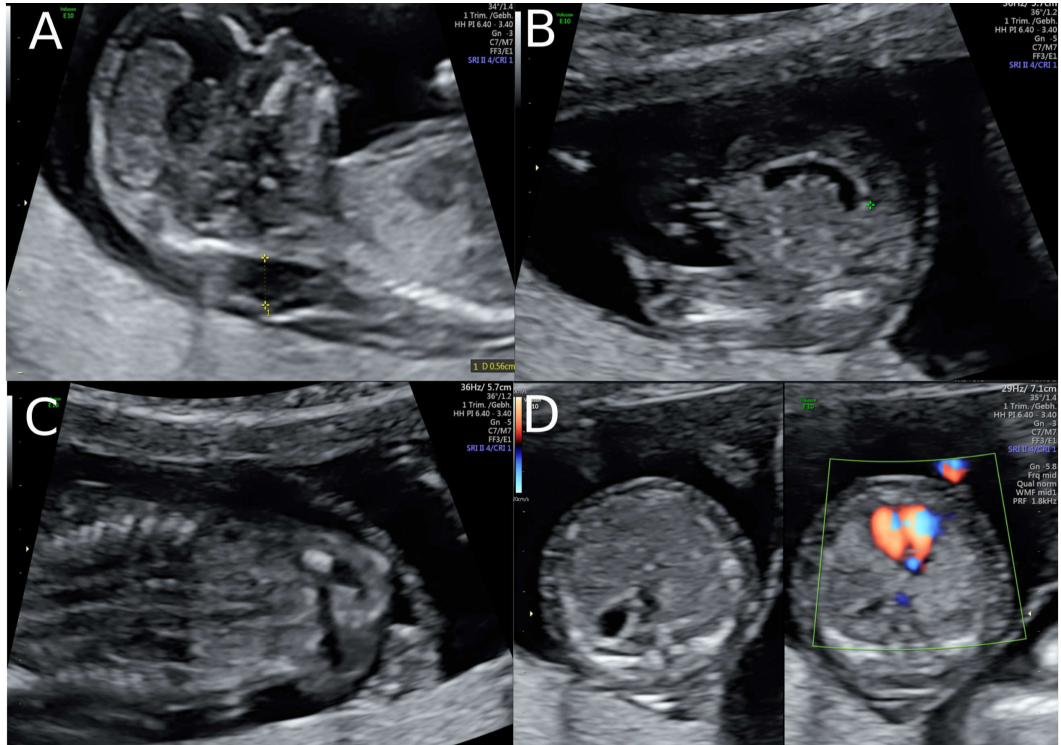
Figure 1. Ultrasound findings in the 1st Trimester. ( A ) Increased Nuchal Translucency (NT) at 13 + 5 weeks of gestation in twin II. ( B ) A simple cystic structure in the abdomen, most probably a gastrointestinal duplication cyst. ( C ) Hyperechogenic kidneys. ( D ) Malposition of the fetal heart in the chest at 13 + 5 weeks. The position of the fetal heart in the middle of the